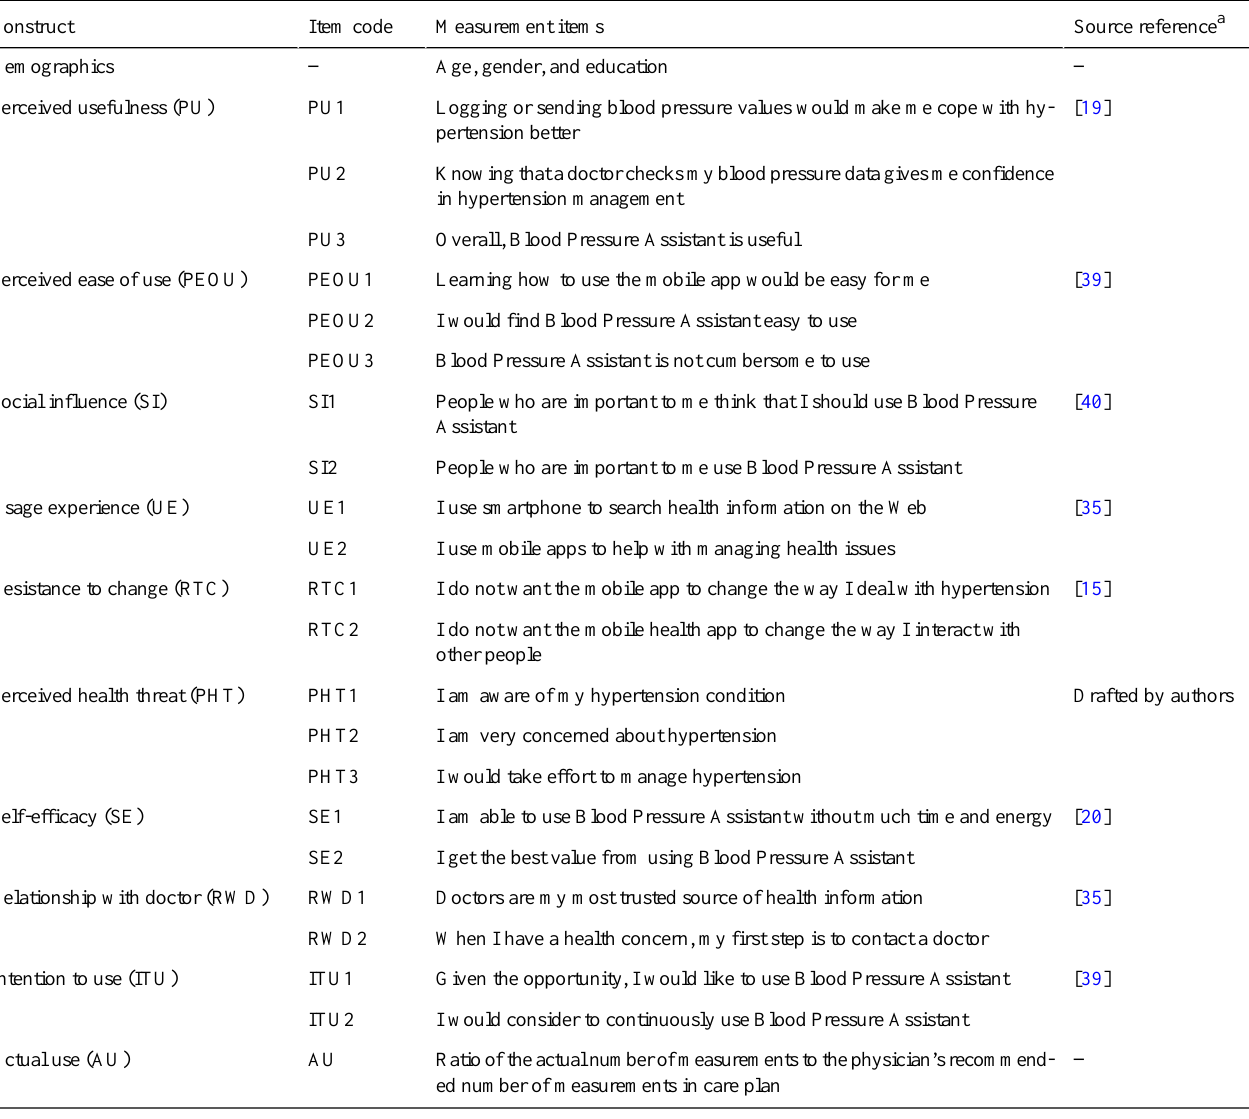
Table 1. The constructs, measurement items, and source references of the measurement